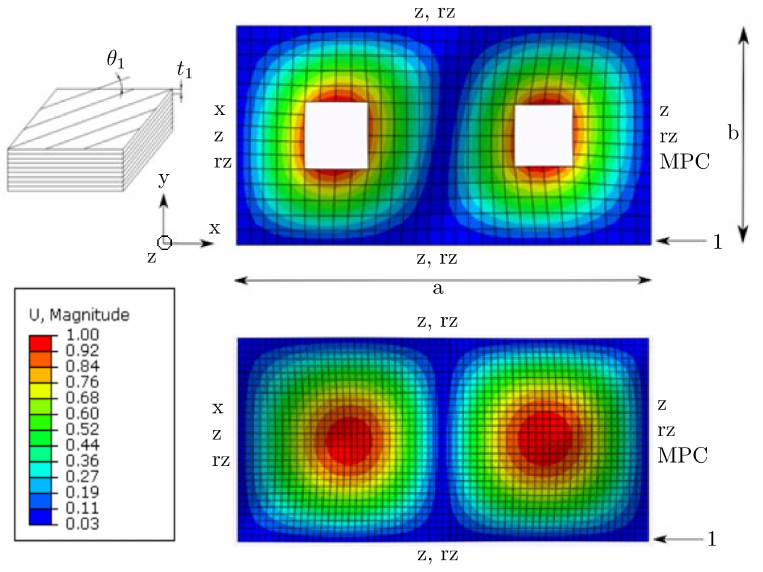
Figure 2. The geometry, boundary conditions, and normalized displacement fields of a laminate with 9 layers.